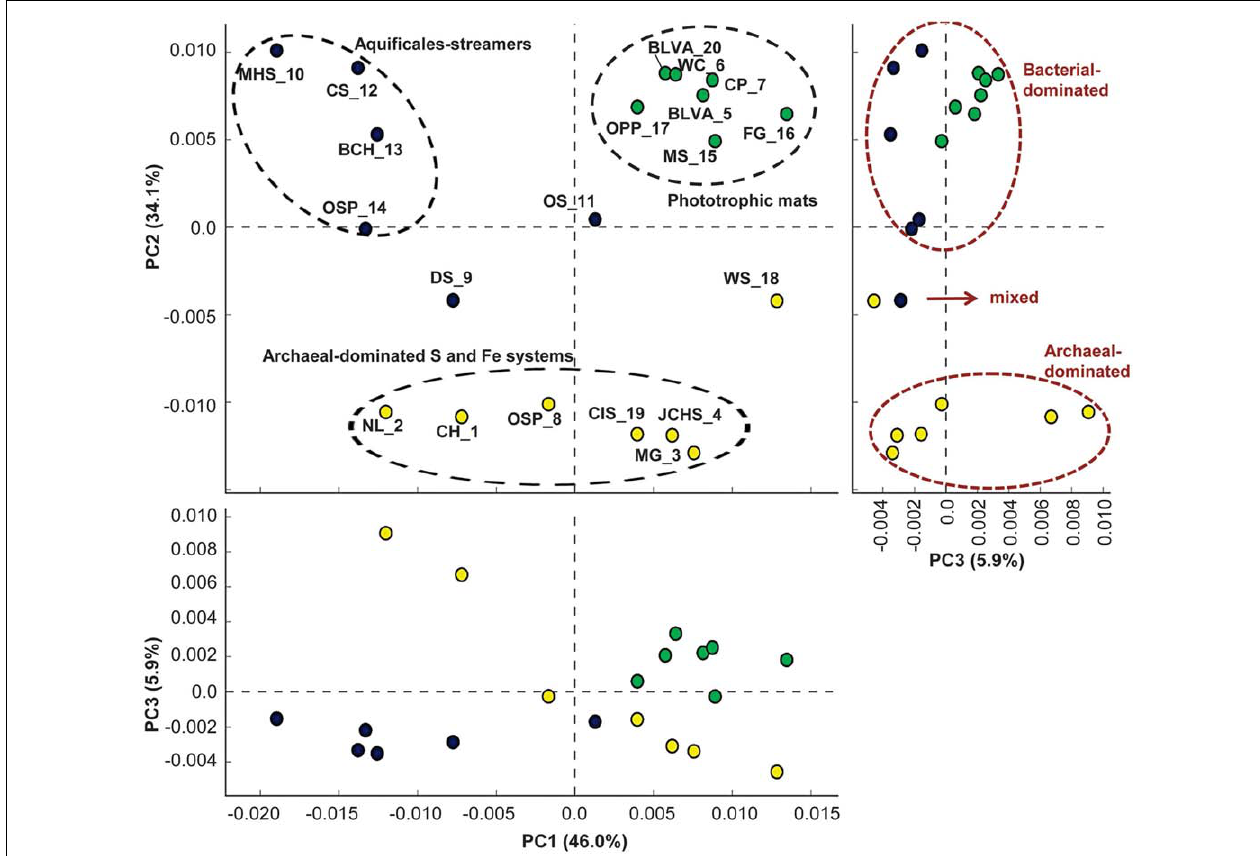
for 80% of the variation across sites, while PC3 only represents ∼ 6%).The first and second components separate sites into the three main habitat types studied (site labels and color groups are described in Table 1